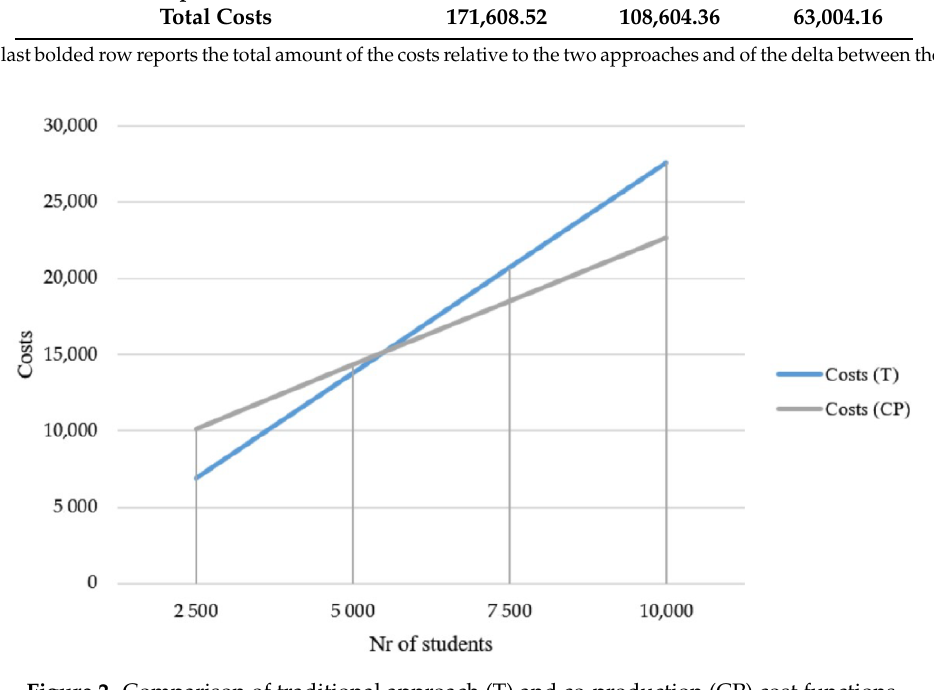
Figure 2. Comparison of traditional approach (T) and co-production (CP) cost functions.